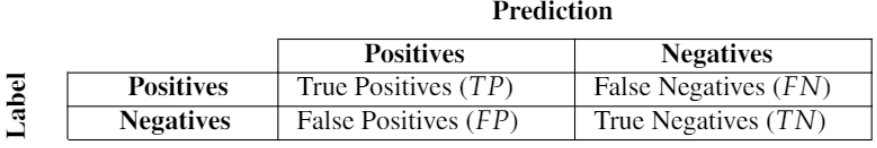
Figure 9. General explanation of confusion